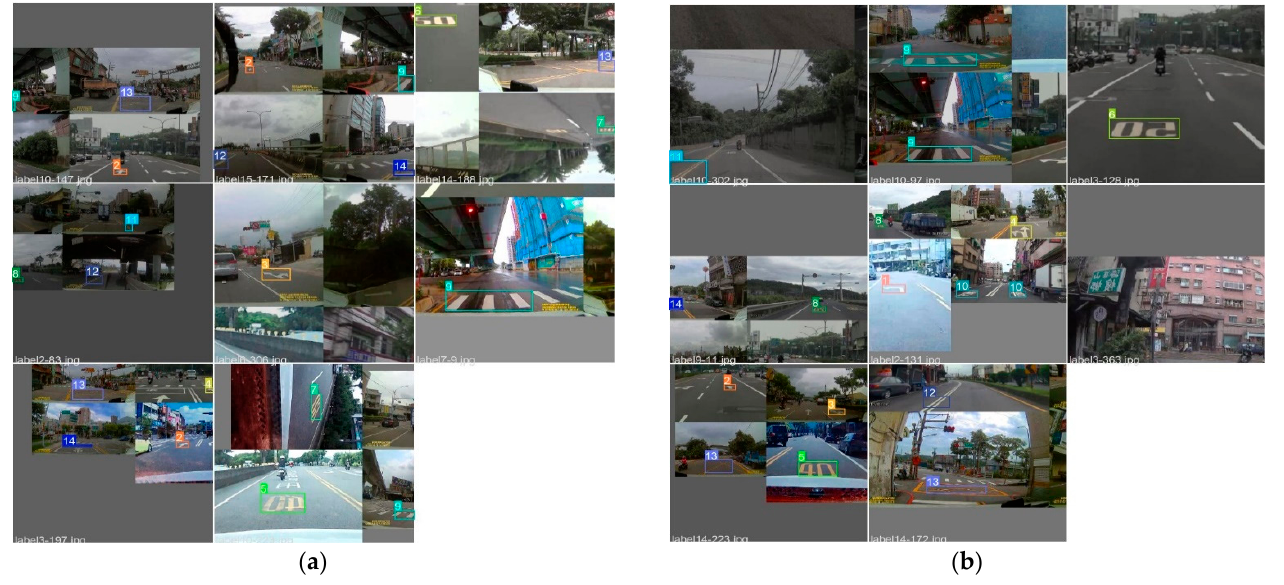
Figure 3. Training Process, ( a ) Batch 0 and ( b ) Batch 1.